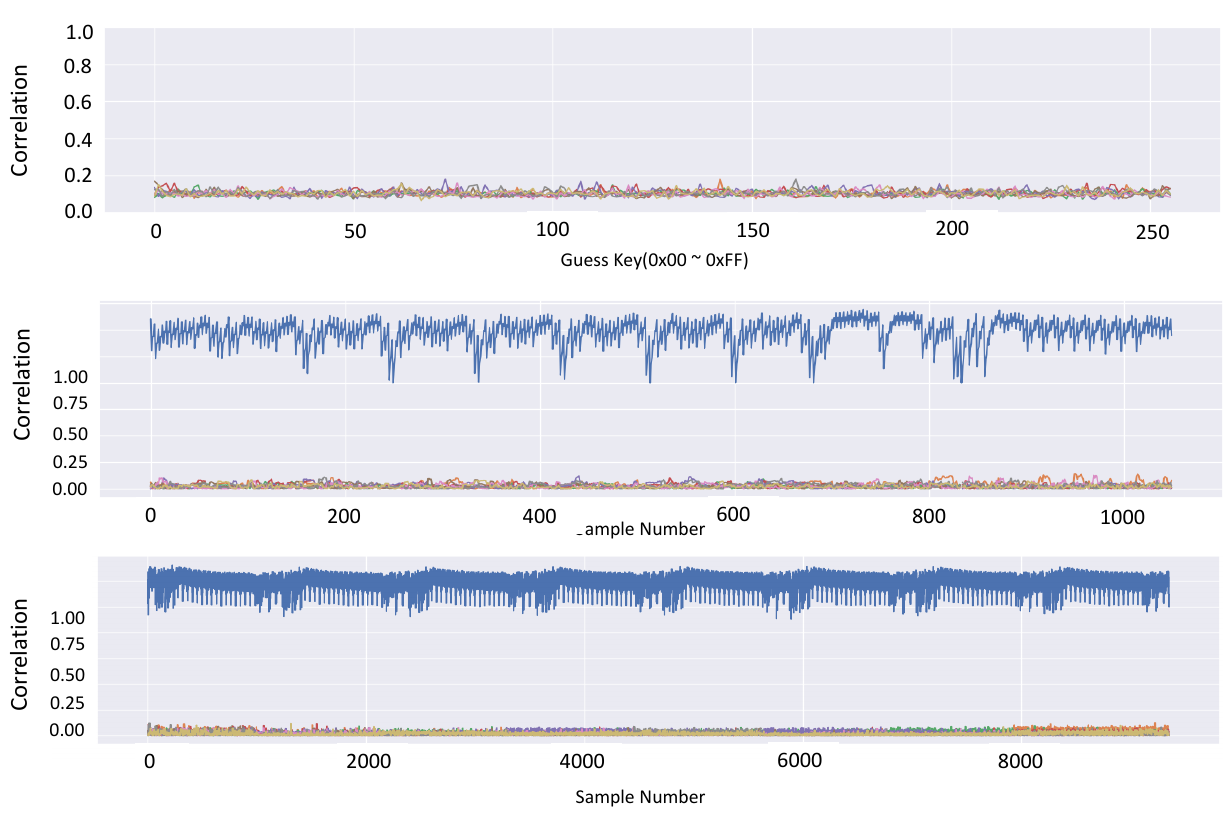
Figure 9. Top: correlation attack results, middle: correlation test results in multiplication, bottom: correlation test results in